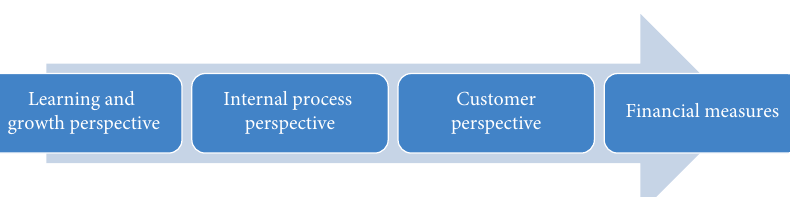
Figure 2: Causal correlation in BSC.